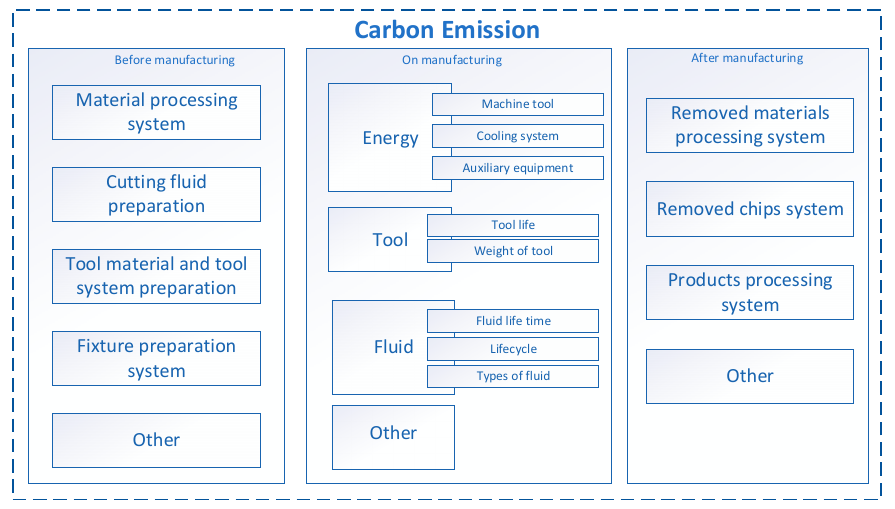
Figure 3. Components of carbon emission of CNC machining system.